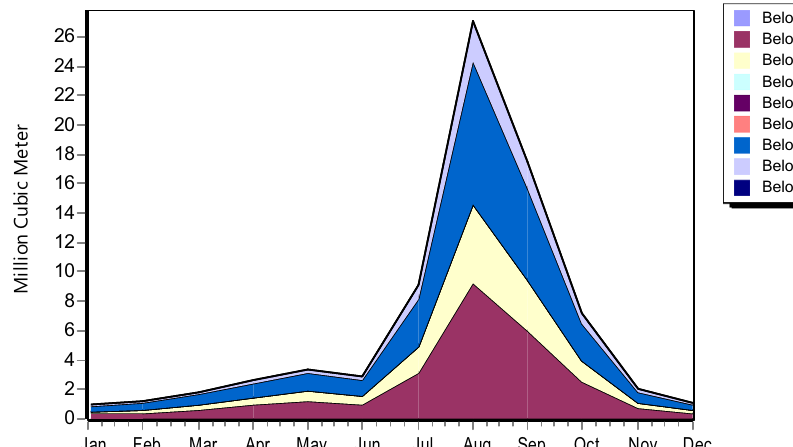
Fig. 8 Average inflows of the sub-catchment